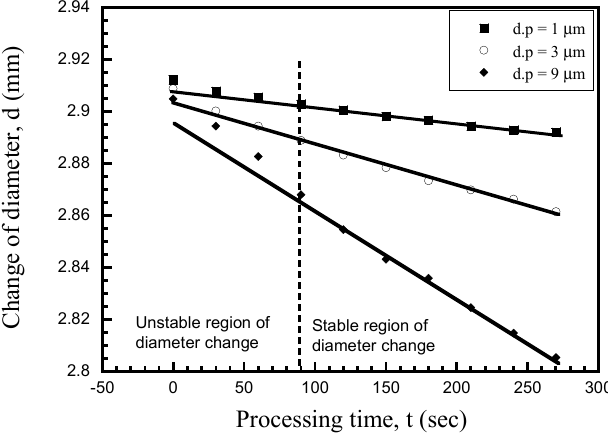
Figure 7. Variations of diameter after processing surface diameter against processing time.